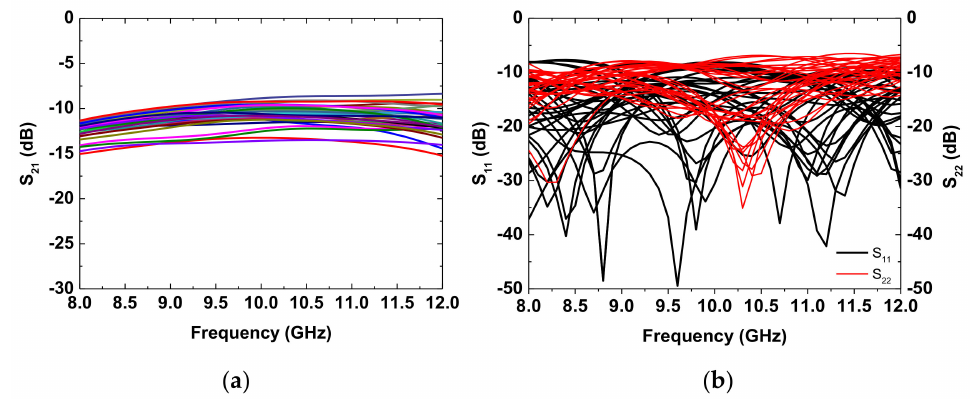
Figure 8. Measured ( a ) insertion loss and ( b ) input/output return loss of all 32 states of the phase